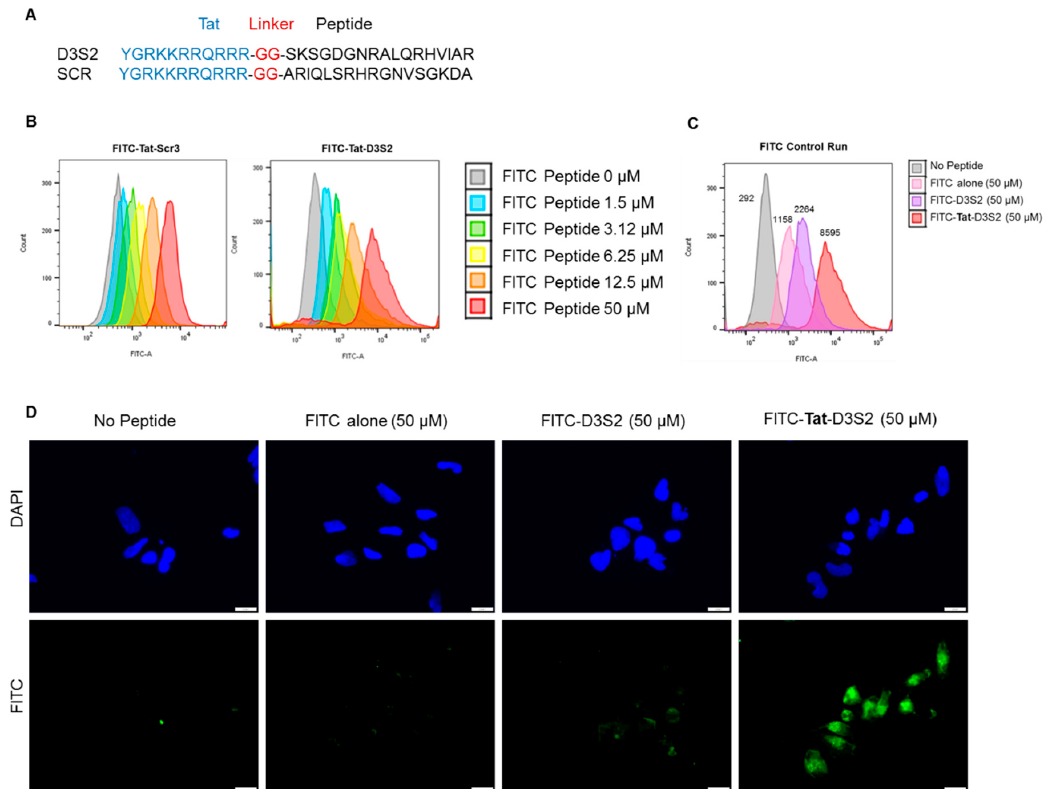
Figure 3. Tat-conjugated DIRAS3 switch II-derived peptide enters ovarian cancer cells in a dose dependent manner. ( A ) Tat-conjugated sequence of the DIRAS3 switch II-derived peptide and its scrambled control. ( B,C ) Flow cytometry quantification of peptide uptake by A2780 ovarian cancer cells incubated with the peptide for 2 h at 37 °C with increasing concentrations of fluorescein isothiocyanate (FITC)-labeled D3S2 peptide. ( D ) Immunofluorescence staining of A2780 ovarian cancer cells following treatment with FITC alone, FITC-D3S2 and FITC-Tat-D3S2. Scale bars indicate 20 nm.